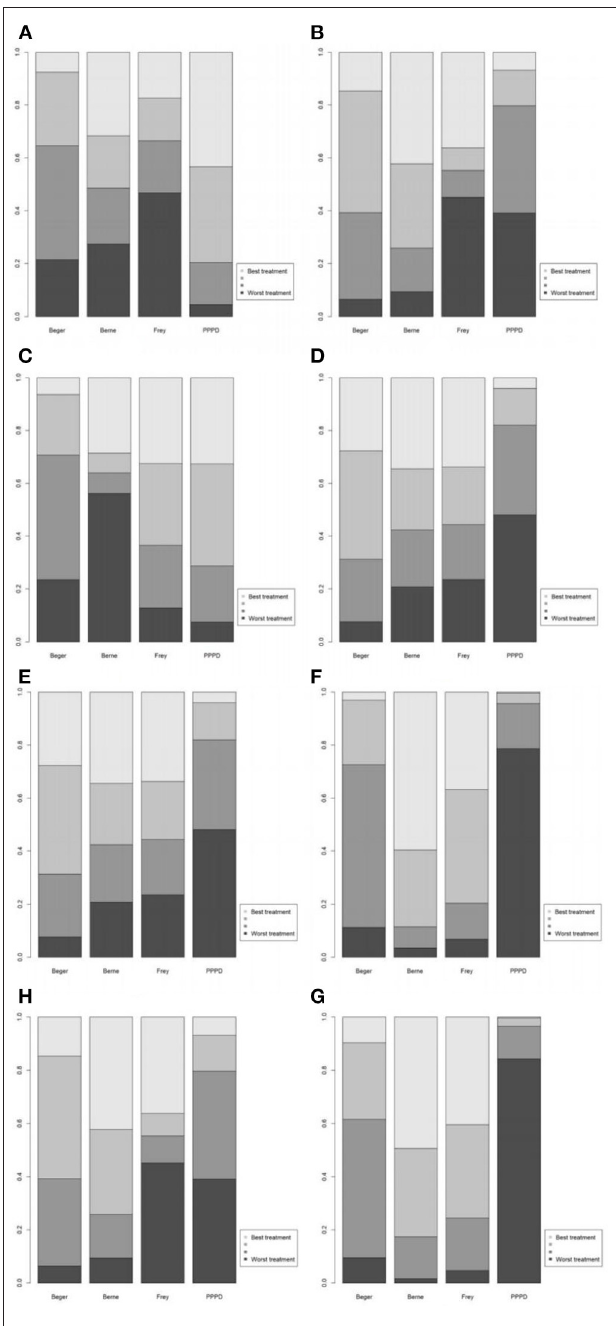
FIGURE 4 | Values of different ranking of the surgical procedures. (A) Short-term pain relief; (B) long-term pain relief; (C) quality of life; (D) pancreatic exocrine function deficiency; (E) pancreatic endocrine function deficiency; (F) morbidity; (G) long-term mortality; (H) operation time.